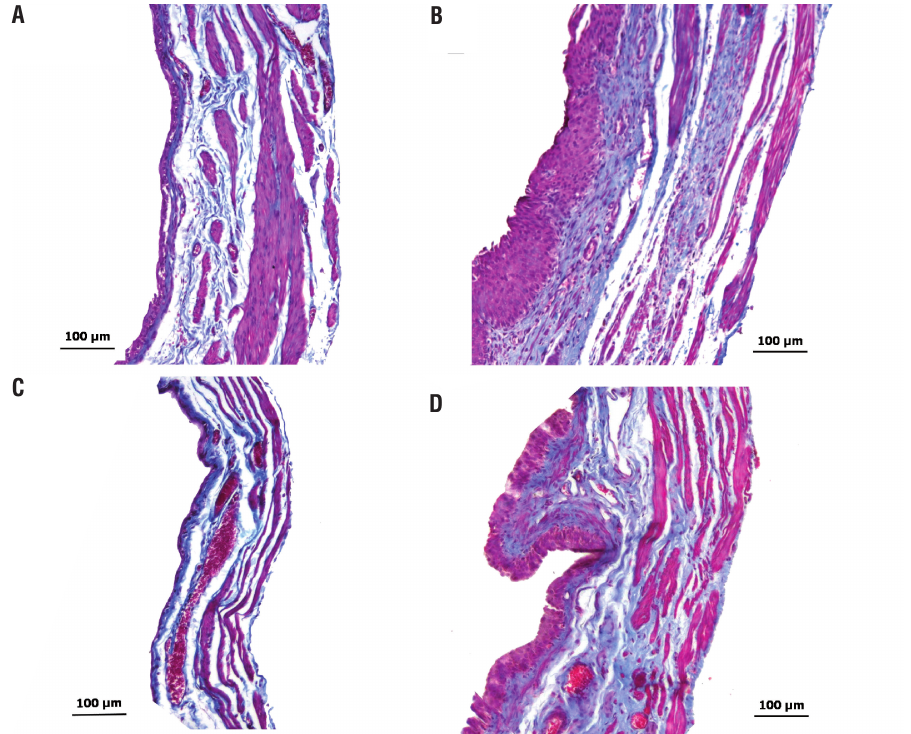
DFigure 5 – Microphotography of sections of the bladder wall in female Wistar rats (A [control], B [autotransplanted bladder 30 days after surgery]), female SRh rats (C [control], and D [syngeneic transplanted bladder 30 days after surgery]). Different layers of the bladder wall show characteristics of preservation of the tissue, maintaining organization and architecture, without signs of fibrosis, wrinkles. There was increased thickening of the bladder wall, especially the epithelium which was thicker than that of the normal urinary bladder. Staining with Masson’s trichrome occurred as described in the experimental